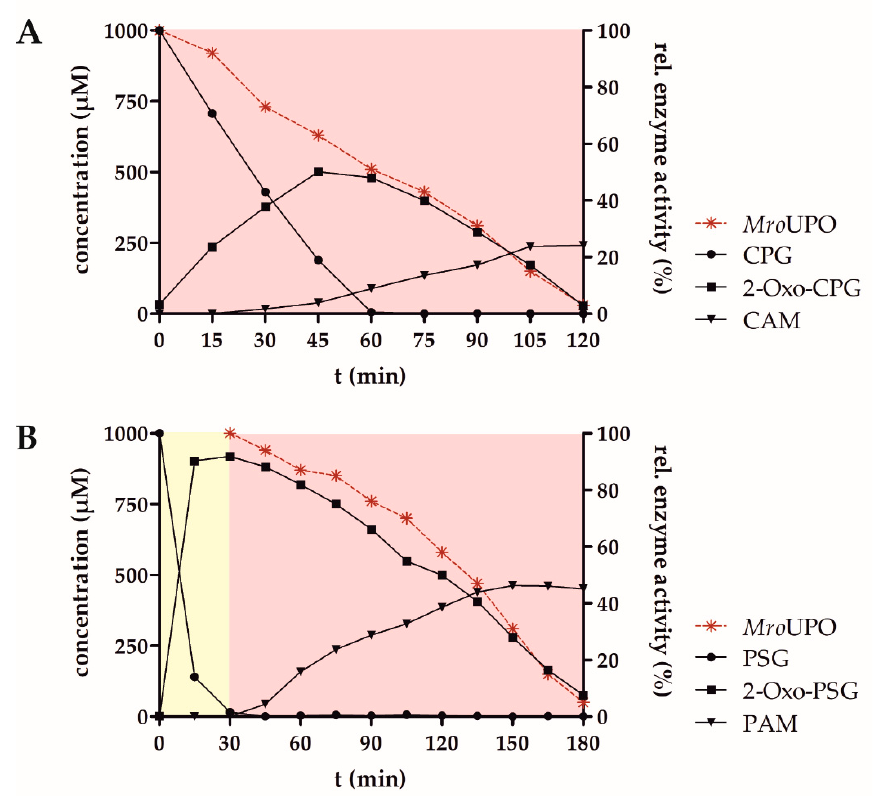
Figure 4. Kinetics of clopidogrel ( A ) and prasugrel ( B ) conversion (0.2 mmol each) by 2 U mL − 1 Mro UPO in presence of 5 mM ascorbate, 20 mM KP i buffer (pH 7.0) and continuous supply of hydrogen peroxide (2 mM h − 1 ). Prasugrel was preincubated with 2 U mL − 1 PLE for 30 min. Black circles are the thienopyridine substrates; black squares represent the 2-oxo metabolites and black triangles are the active metabolites. Isomeric double peaks were merged. The red stars reflect the residual UPO activity. Yellow background represents the PLE reaction; red background indicates the UPO reaction. Ordinates are the concentrations of the metabolites recalculated after calibration with isolated